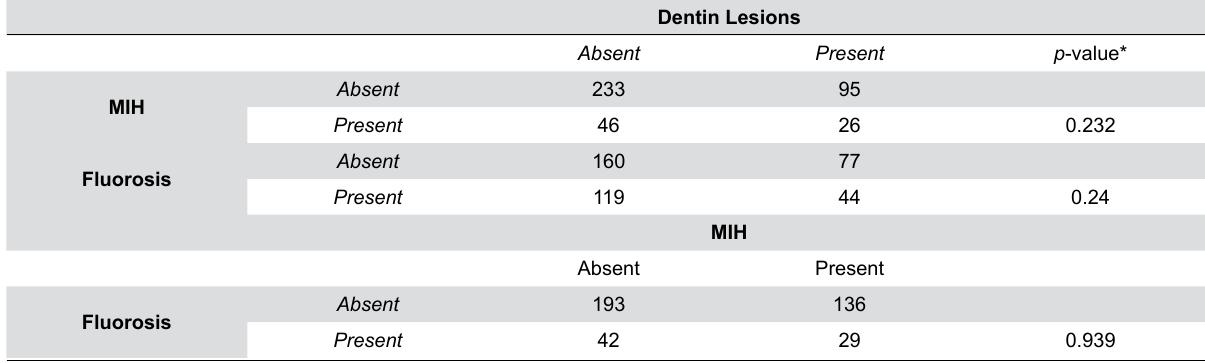
Table 4- Frequency and statistical analysis of the three dental conditions (DC, DF, MIH) at the individual level